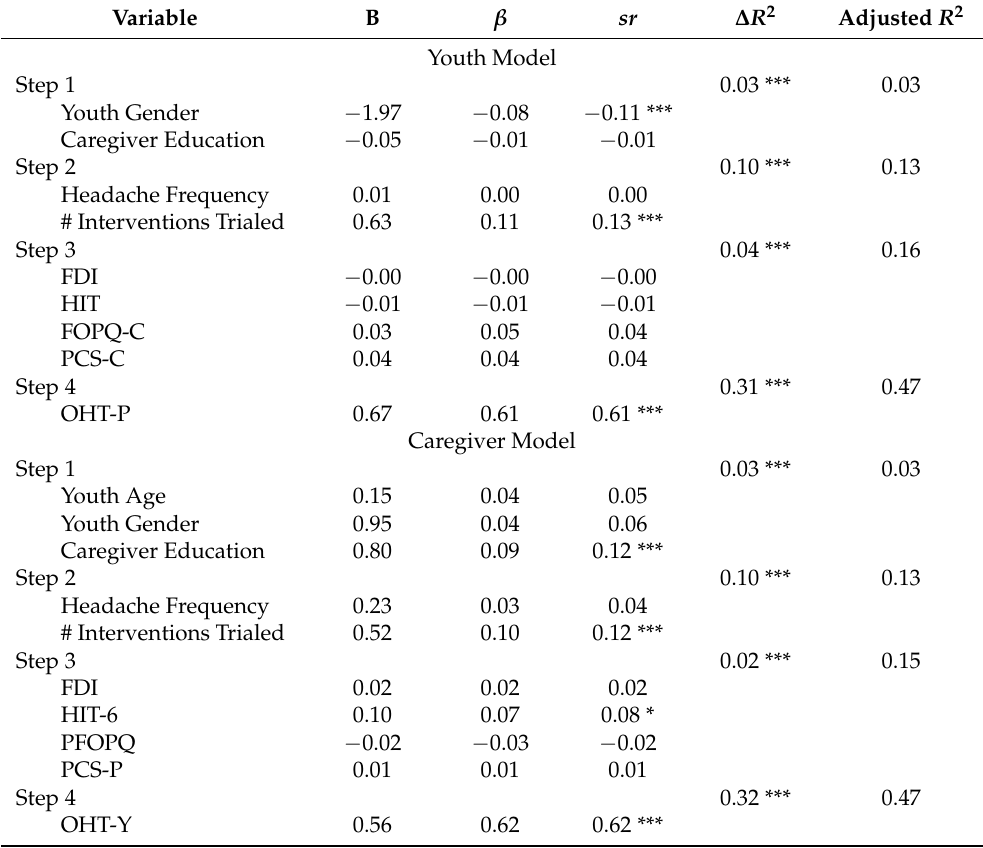
Table 6. Hierarchical Regressions Predicting Youth and Caregiver